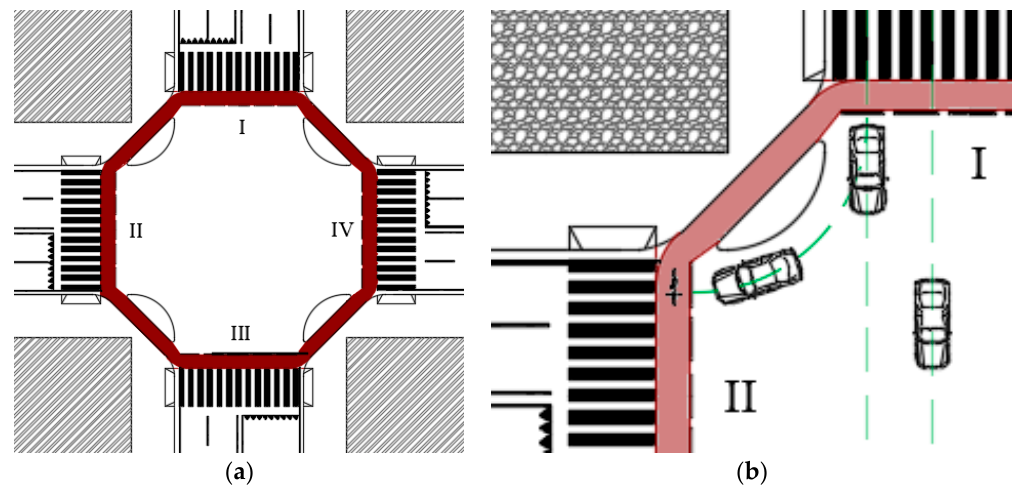
Figure 4. Layout of L12: ( a ) geometrical configuration; ( b ) focus on operational performance.